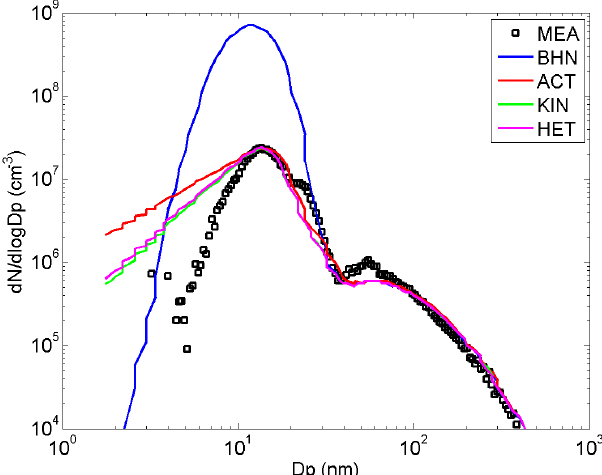
Figure 4. Comparison of measured and modelled particle size distributions, considering different nucleation mechanisms. En- gine load was 100%, initial GSA = 2.0 × 10 12 cm − 3 , COV s = 6 × 10 11 cm − 3 , except for BHN it was 8 × 10 12 cm − 3 . The sim- ulation time was 2.7s. Black squares refer to the measured size dis- tribution by the SMPS after the ageing